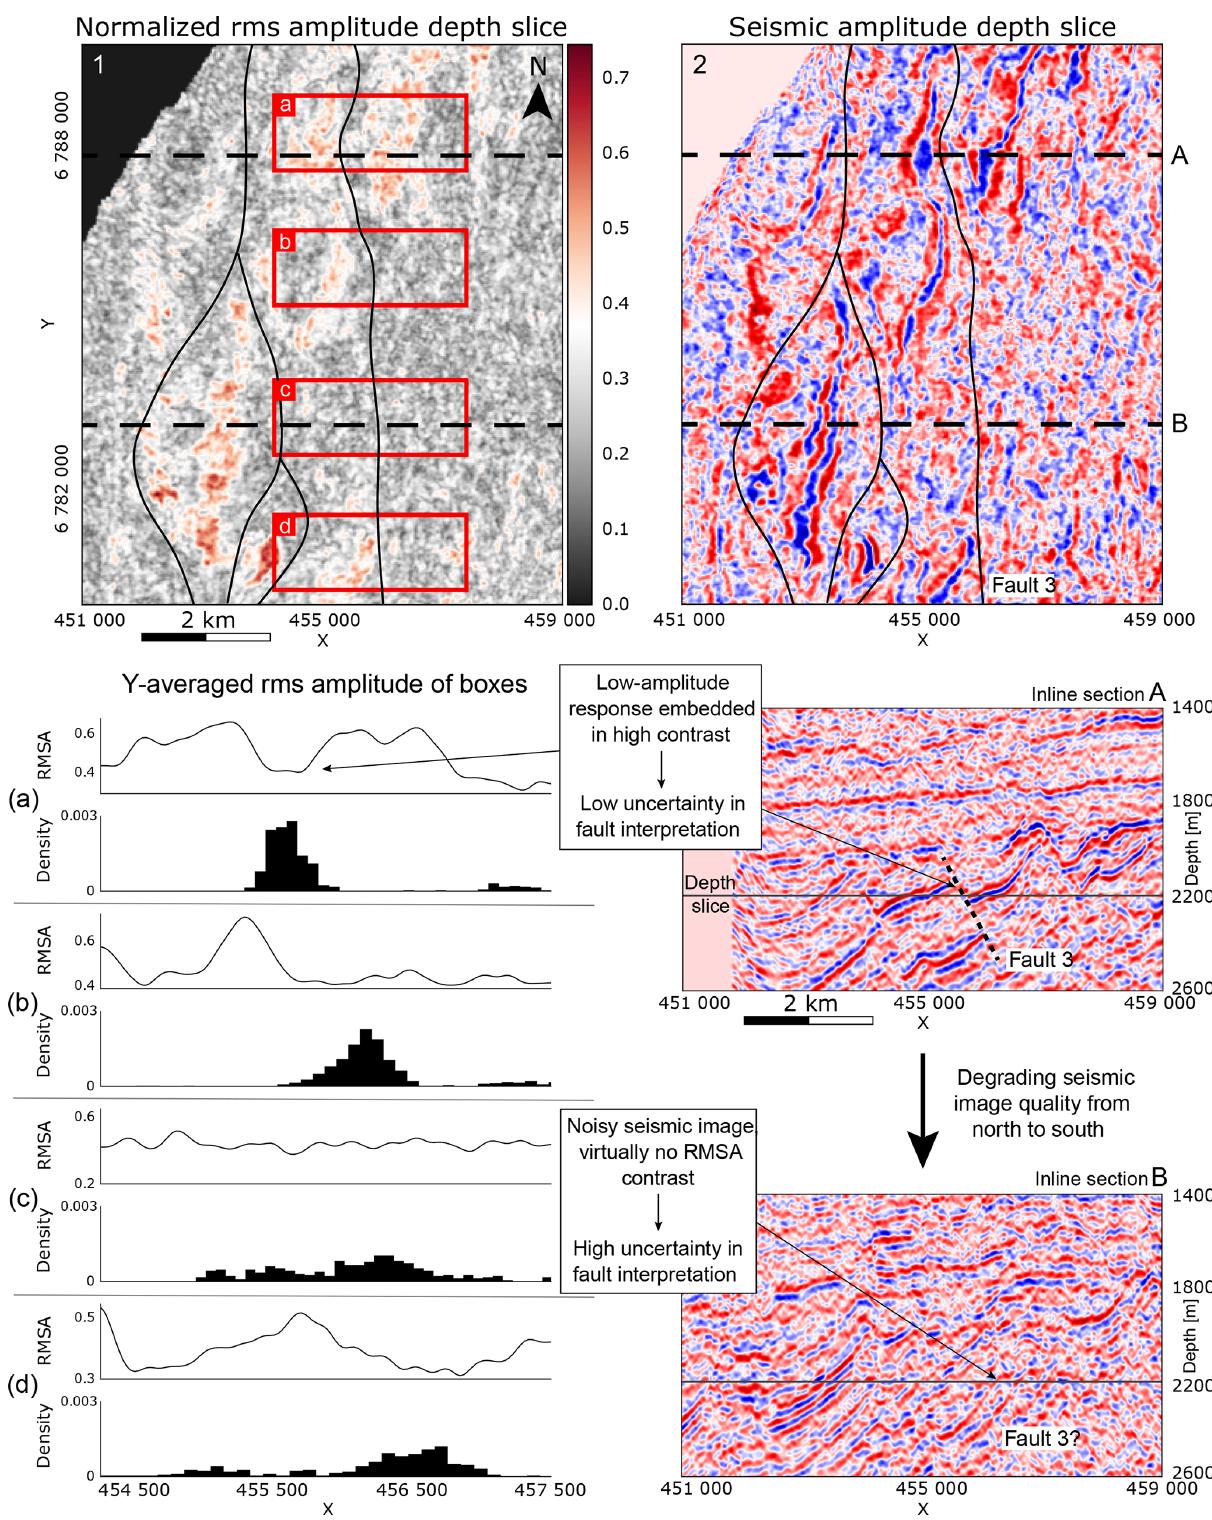
Figure 8. Depth slice of RMSA attribute (1) and seismic cube (2) with locations (black horizontal lines) of two inline sections (A, B). Four averaged RMSA responses with corresponding student Fault 3 stick interpretations are plotted in panels (a) – (d) , with their locations noted in the RMSA depth slice (1) . The inline sections (A and B) correspond to the RMSA responses in panels (a) and (b) , respectively.